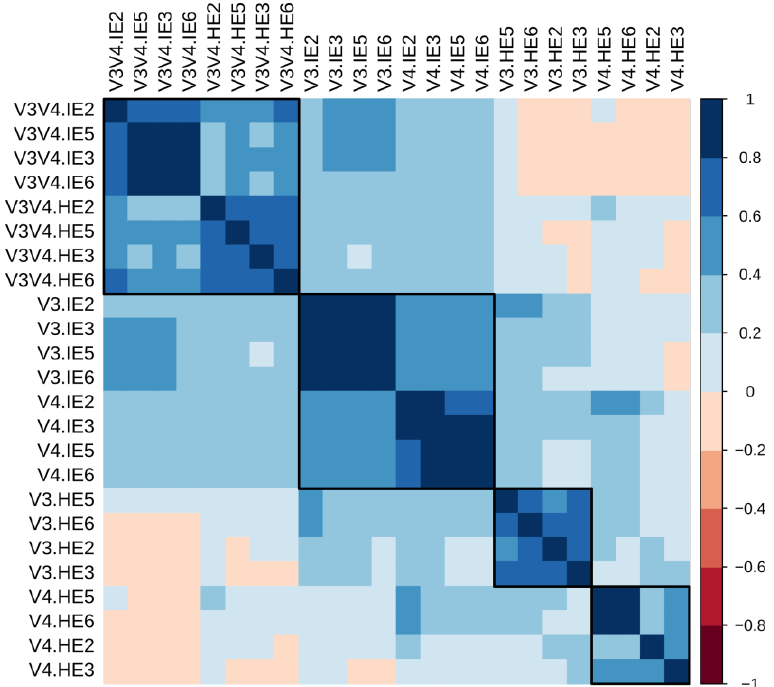
Figure 10. Correlation heatmap comparing the distribution of genera among all samples. Heatmap shows WPGMA hierarchical clustering of the samples according to their genera distribution similarities. The scale of variation was set to a discrete scale rather than a gradient for a more straightforward interpretation. Clustering showed as black square linings support the existence of a series of samples with genera distribution.